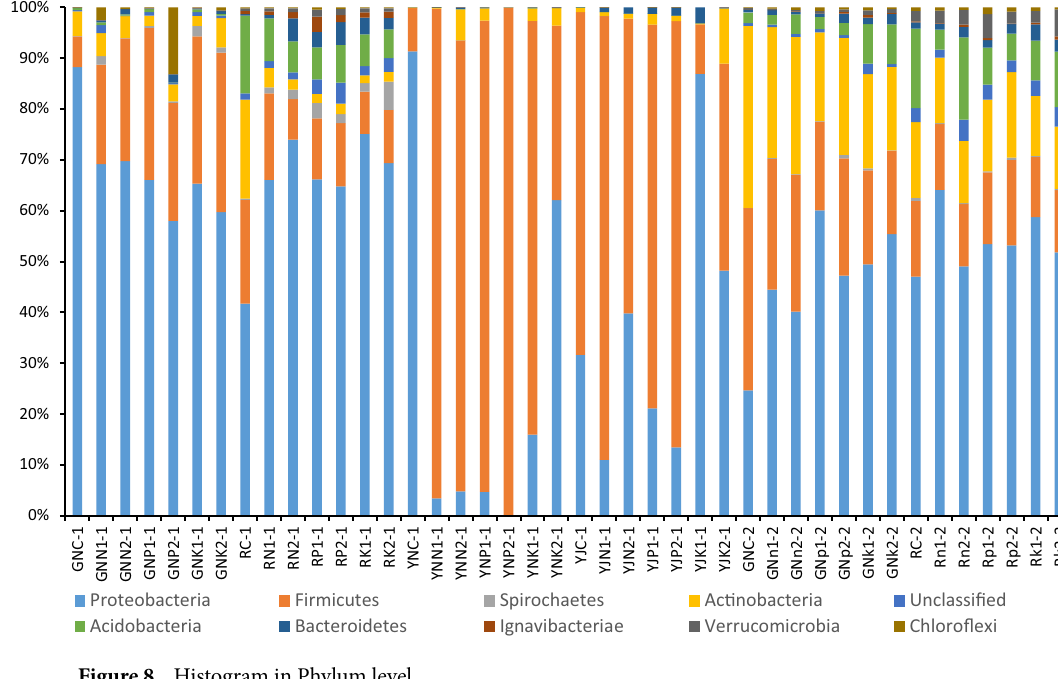
Figure 8. Histogram in Phylum level.